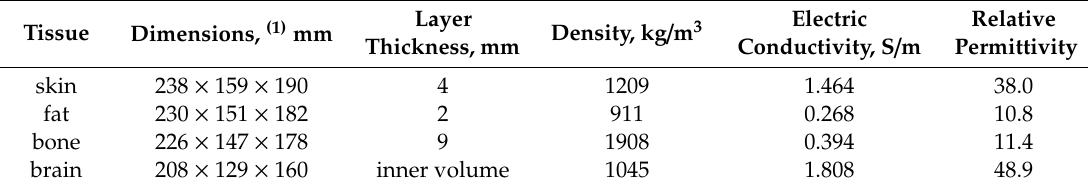
Table 1. Dimensions and parameters at 2.45 Hz of tissues considered in the numerical model of the head (a multi-layer ellipsoid).